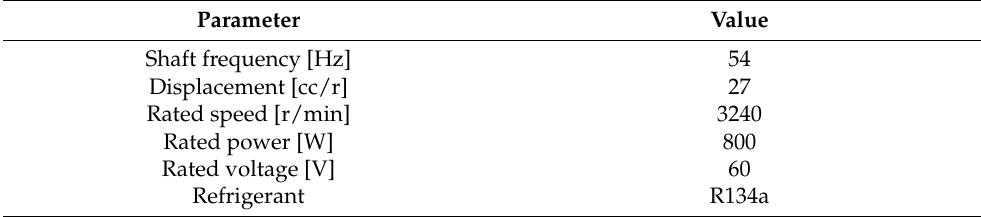
Figure 3. Experimental platform schematic diagram. Table 1. Parameters of scroll compressor.